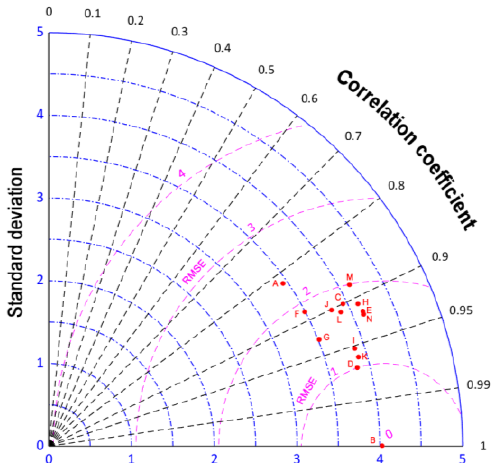
Figure 11. The Taylor diagram of the forecasting results (A: Multi-Regress; B: Actual; C: EMD- LSTM; D: EMD-MBES-LSTM; E: EMD-PSO-RBFF; F: PSO-RB; G: EMD-PSO-SVM; H: PSO-SVM; I: EMD-PSO-LSTM; J: PSO-LSTM; K: EMD-BES-LSTM; L: BES-LSTM; M: LSTM; N: MBES-LSTM).